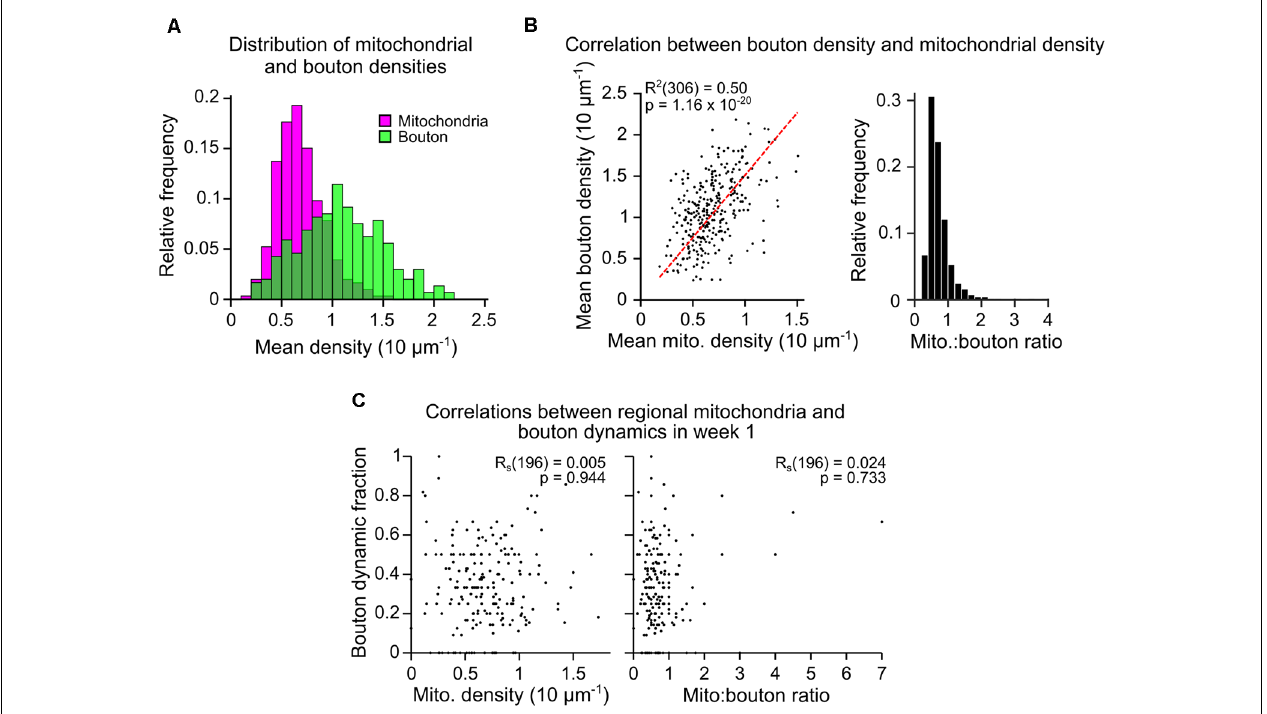
FIGURE 2 | Mitochondrial density along an axonal segment is correlated to bouton density but not bouton dynamics. (A) Mitochondrial and bouton density distributions for all axons (mean across time, n = 306 axons). (B) (left) Bouton and mitochondrial densities for each axon were strongly correlated (mean across time; R 2 = Pearson’s correlation, n = 306). Red dashed line = linear regression. (right) Histogram showing the distribution of mitochondrion-to-bouton ratios for all axons (median = 0.65, approximately two mitochondria to every three boutons). (C) Example correlations between the fraction of boutons on each axon that were dynamic (lost or gained; bouton dynamic fraction ) and either: (left) the number of mitochondria relative to the number of boutons (mito:bouton ratio), or (right) mitochondrial density. Results from the first weekly interval (between days 7 and 14) are shown ( n = 196 axons over all weekly intervals, R S = Spearman’s rank correlation, see Supplementary Table S1